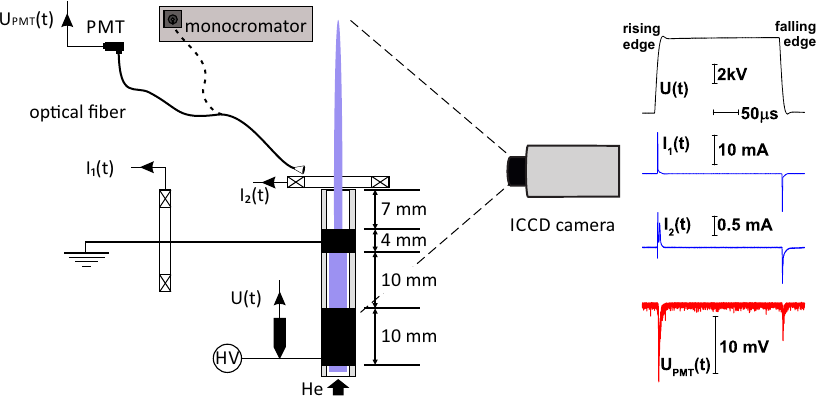
Figure 1. Sketch of the experimental set-up ( left side , not drawn to scale ); typical signals for positive polarity high voltage pulses, I 1 , I 2 currents and photomultiplier (PMT) signal ( right side